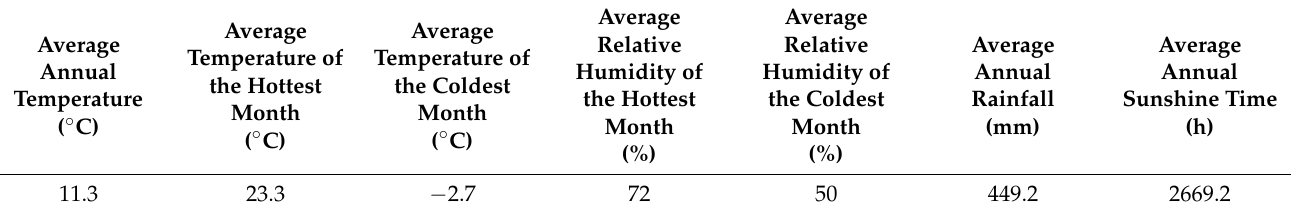
Table 2. Environmental characteristics of Taiyuan (2013–2020).